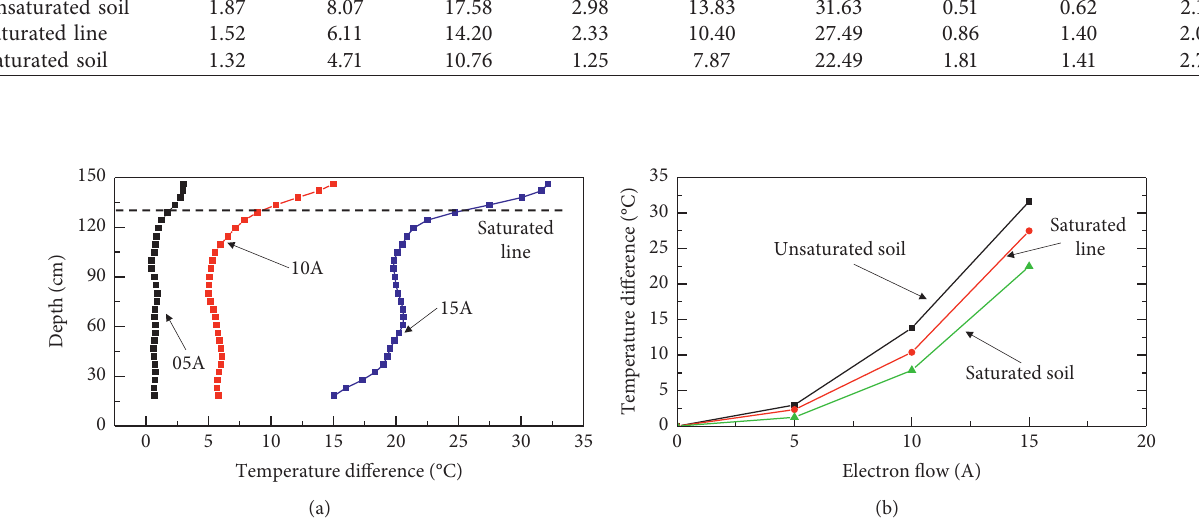
Figure 7: Distribution of temperature difference along (a) height and (b) electron